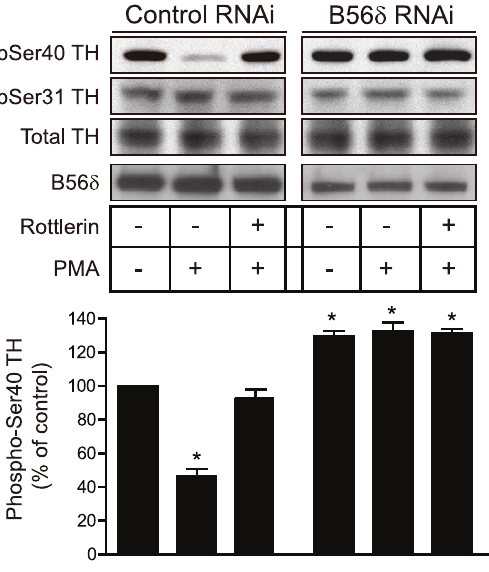
Figure 5. PMA-dependent dephosphorylation of Ser40 in tyrosine hyroxylase is inhibited by down-regulation of B56 d . N27 cells were infected with either AAV-control RNAi or AAV-B56 d RNAi for 48 h. N27 cells were then pretreated with either vehicle or rottlerin (5 m M) for 30 min, then treated with PMA (10 nM) for 10 min as indicated. Phosphorylation of Ser40 and Ser31 of tyrosine hyroxylase was measured as above. B56 d levels were measured by immunoblot- ting. The bar graph shows quantification of immunoblot data normalized in each experiment to control as means 6 s.e.m. (n=3). *, P , 0.001 compared with vehicle-treated control by one-way ANOVA protein in control RNAi cells compared to 3.69 6 0.21 m g/mg protein in B56 d RNAi expressing cells.